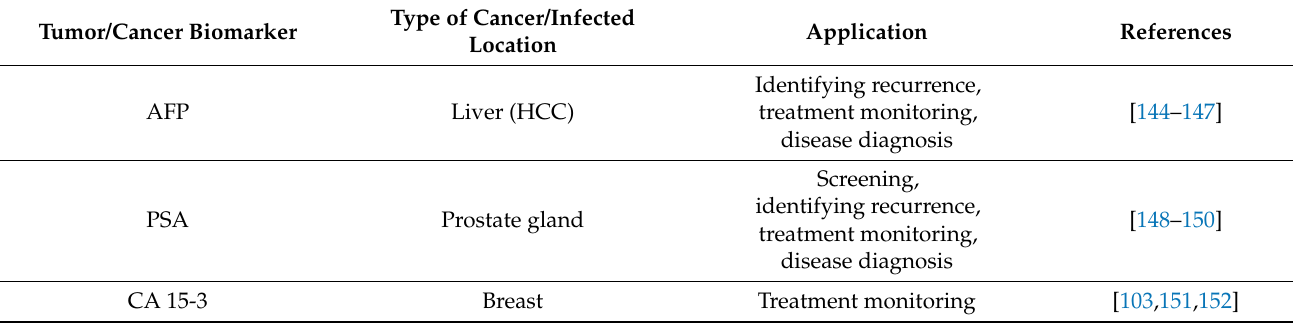
Table 1. Biomarkers used in cancer